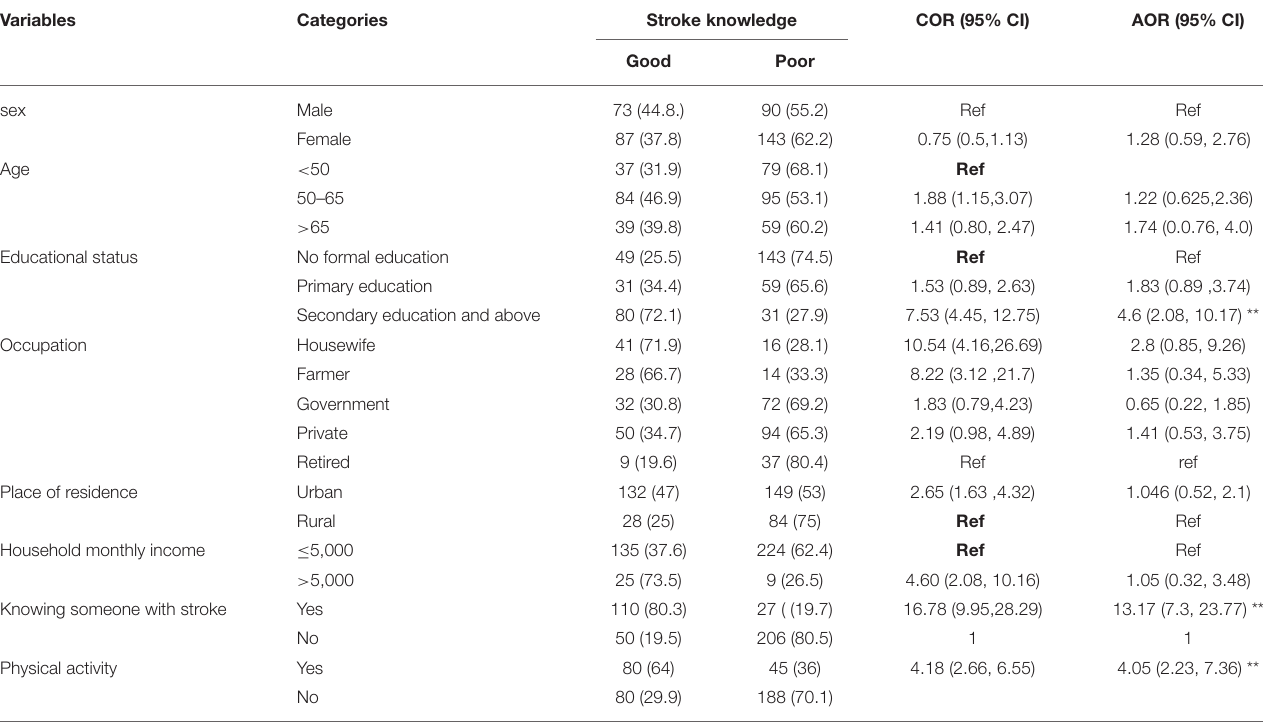
TABLE 6 | Factors associated with stroke knowledge in hypertensive patients attending in chronic illness follow-up clinic of University of Gondar Comprehensive Specialized Hospital, Northwest, Ethiopia, 2021 ( n = 393).